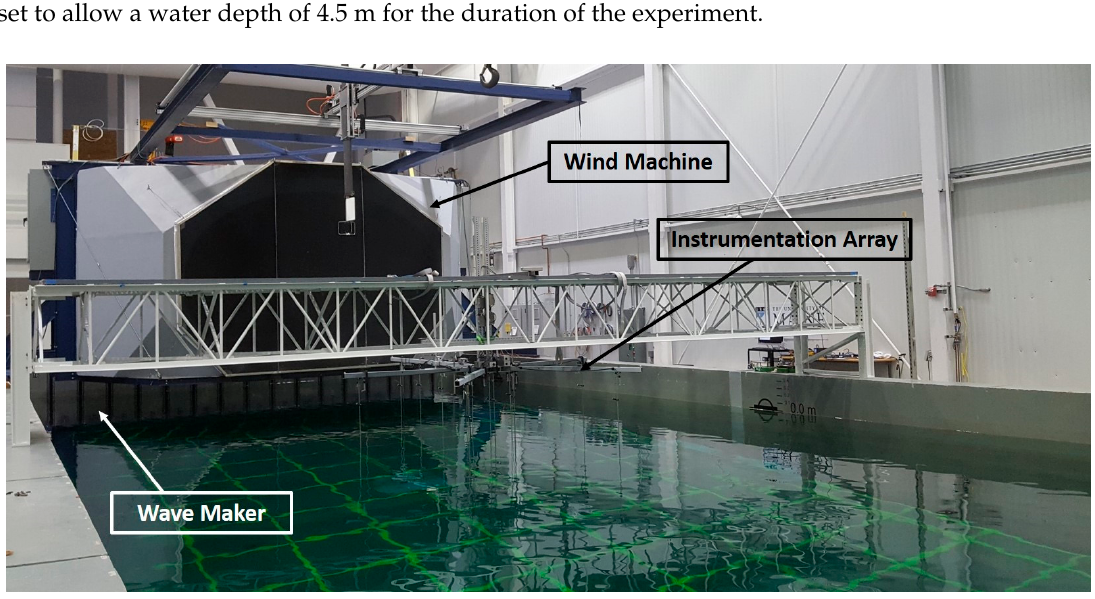
Figure 1. W 2 Basin in the Advanced Structures and Composites Center (ASCC) at the University of Maine. The wind machine is located above the 16-paddle flap wave generator over the 30 m long by 9 m wide